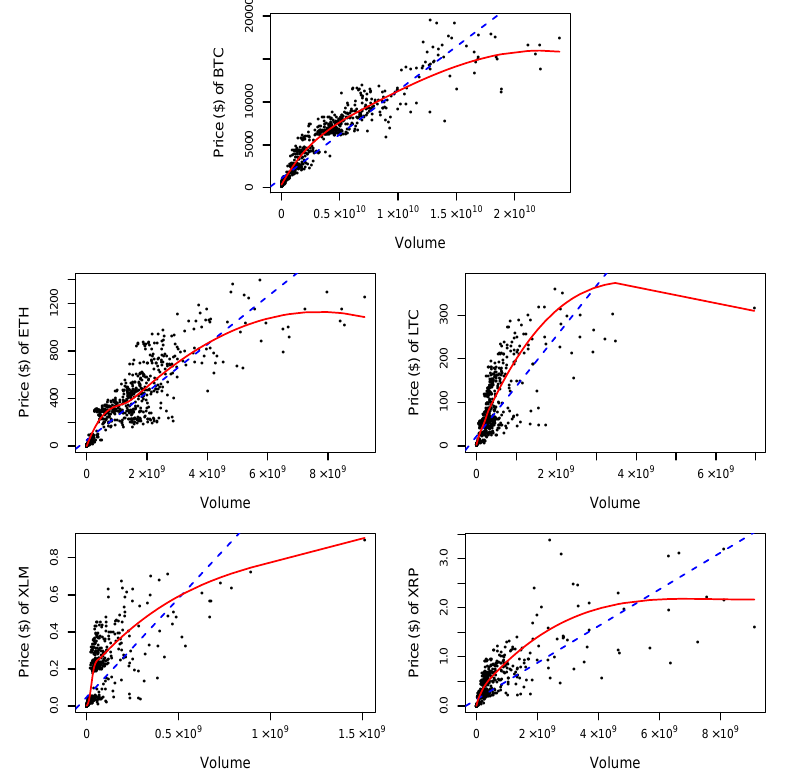
Figure 5. Linear and LOESS regression models between prices and volumes of the five cryptocurrencies: linear fit (dashed line) and LOESS fit (solid